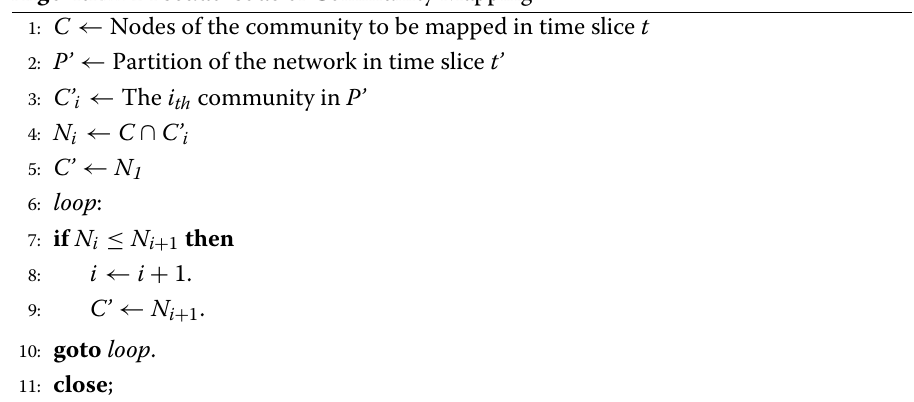
Algorithm 1 Pseudo-code of Community Mapping